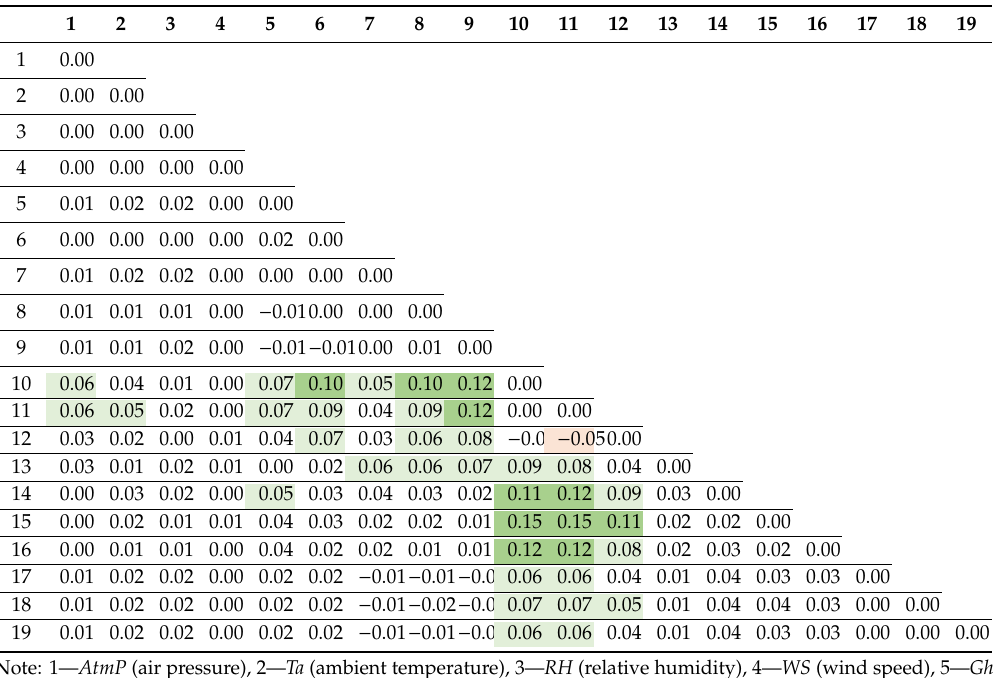
Table 7. Matrix of di ff erences between correlation coe ffi cients obtained using 1 and 10 min aggregation